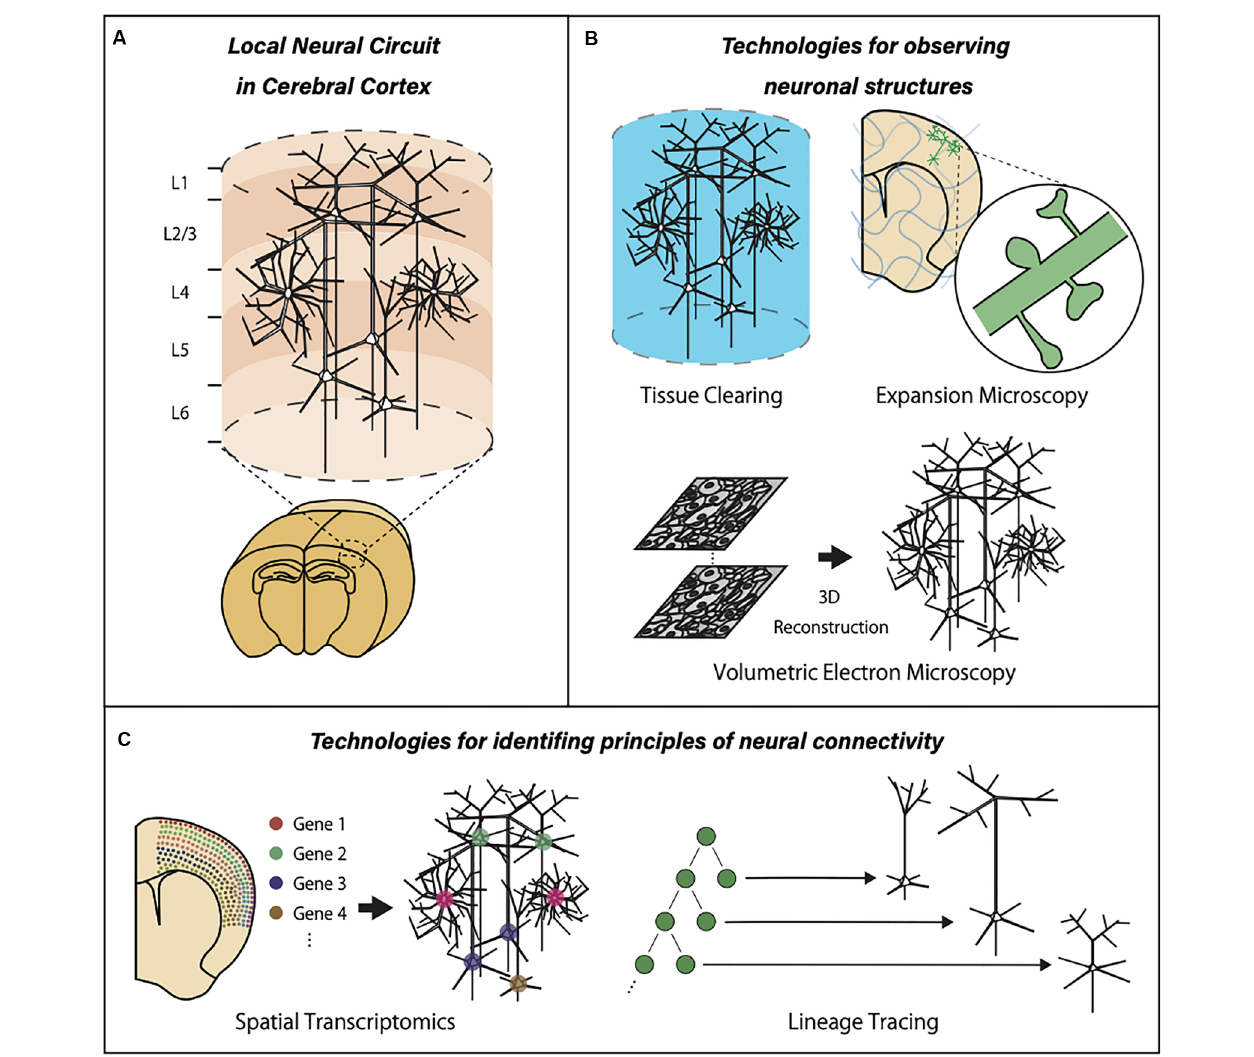
FIGURE 1 | Graphic summary of neurotechnologies for local neural circuits in the cerebral cortex. (A) The cerebral cortex is organized with many units of locally connected neurons extending the entire cortical layers. (B) Optical clearing methods, expansion microscopy, and a large-volume EM reconstruction allow three-dimensional observation of the large brain volume with subcellular resolution. (C) The advancements of spatial transcriptomics and cell lineage tracing provide valuable information about gene expression patterns and developmental events within local neural circuits.